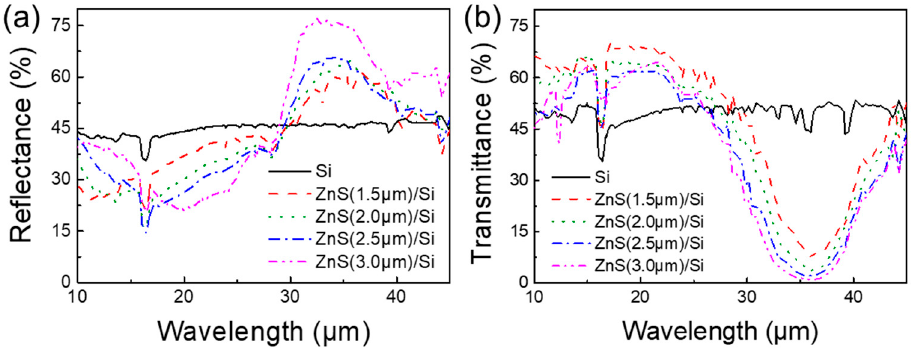
Figure 3. ( a ) Reflectance and ( b ) transmittance spectra of bare Si substrate and ZnS/Si structures, where the thicknesses of the ZnS layers were 1.5, 2.0, 2.5, and 3.0 μ m,